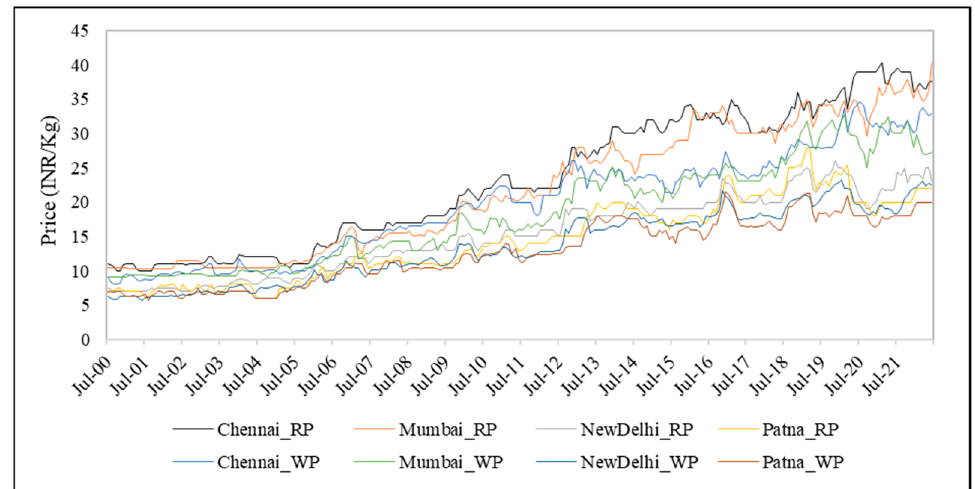
Figure 1. Price trends in selected rice markets of India.